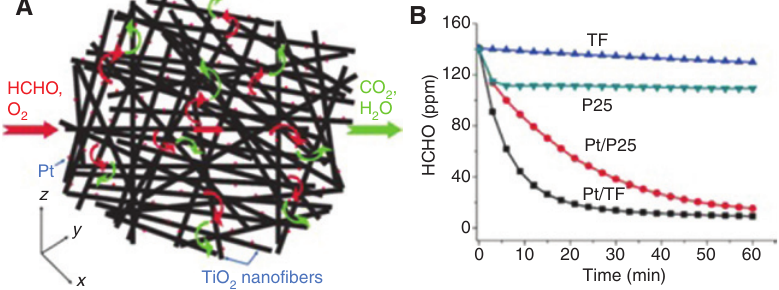
and HCHO) and products (CO and H O) in the hierarchically porous channel of 2 2 2